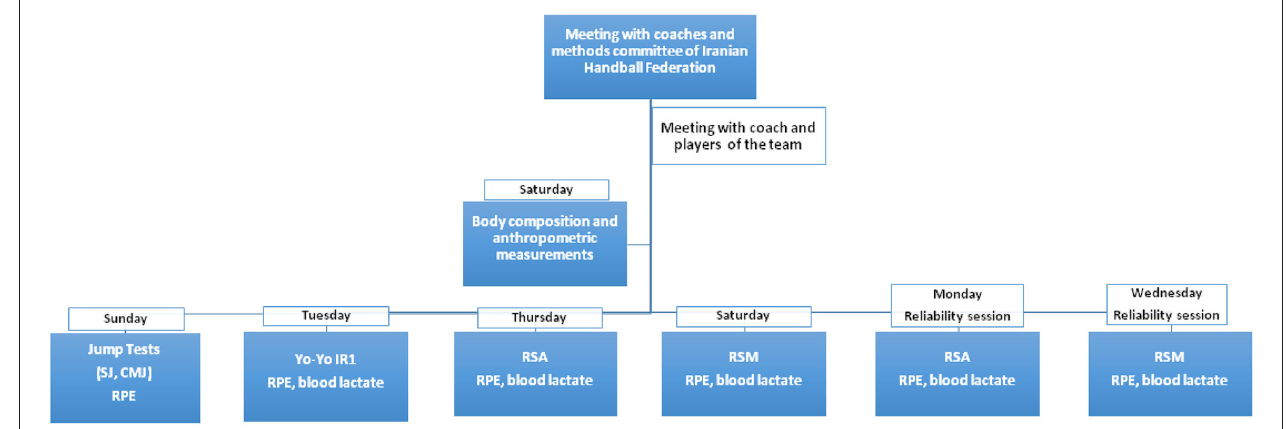
FIGURE 1 | Experimental design of the study. SJ, squat jump; CMJ, countermovement jump; RPE, rate of perceived exertion; Yo-Yo IR1, Yo-Yo intermittent recovery test level 1; RSA, repeated sprint ability test; RSM, multi-directional repeated sprint ability test.